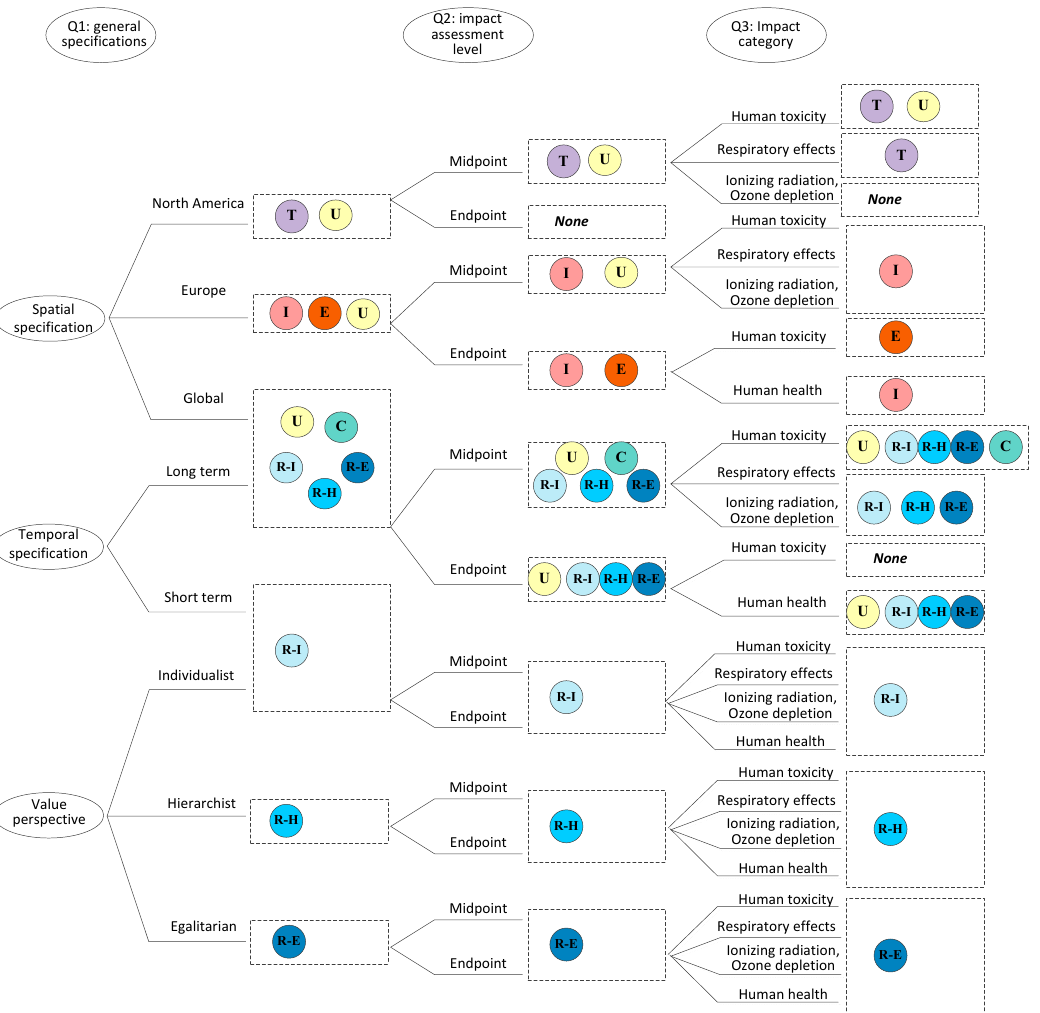
Figure 6. Schematic presentation of an example of the decision tree to identify the appropriate LCIA method(s).